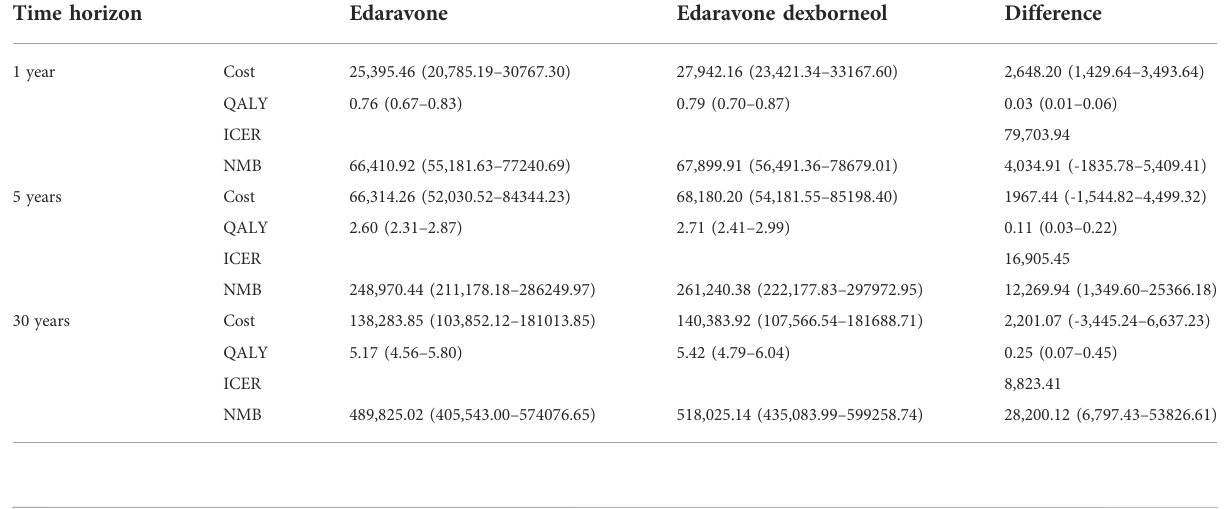
TABLE 2 Cost-effectiveness results of edaravone versus edaravone dexborneol. Time horizon